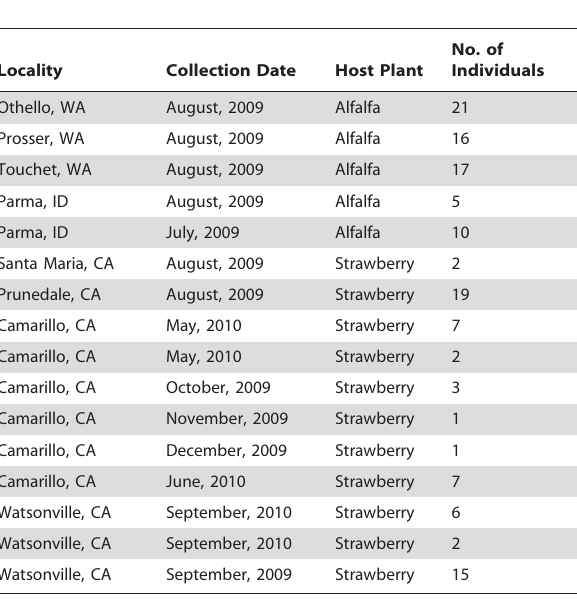
Table 1. Collection information for populations of Lygus hesperus Knight in this